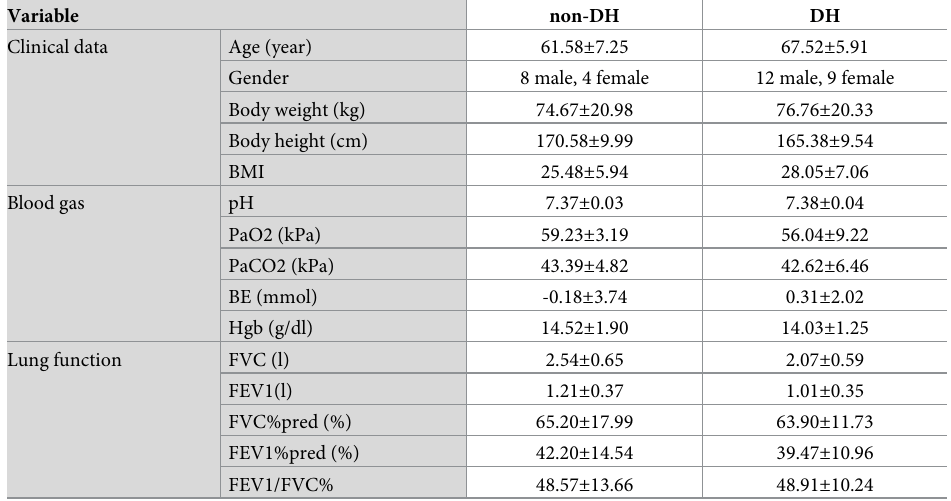
Table 1. Patient demographics, blood gas analysis, and lung function by DH and non-DH